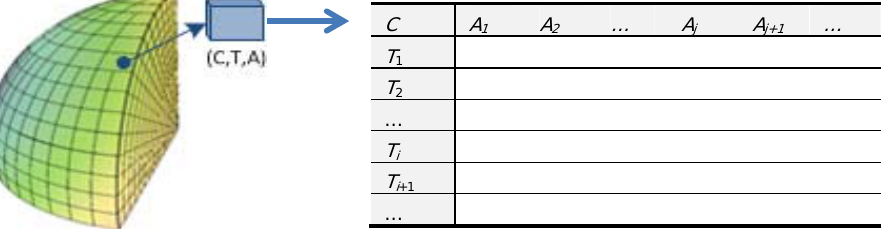
Figure 3 CTA-based big data